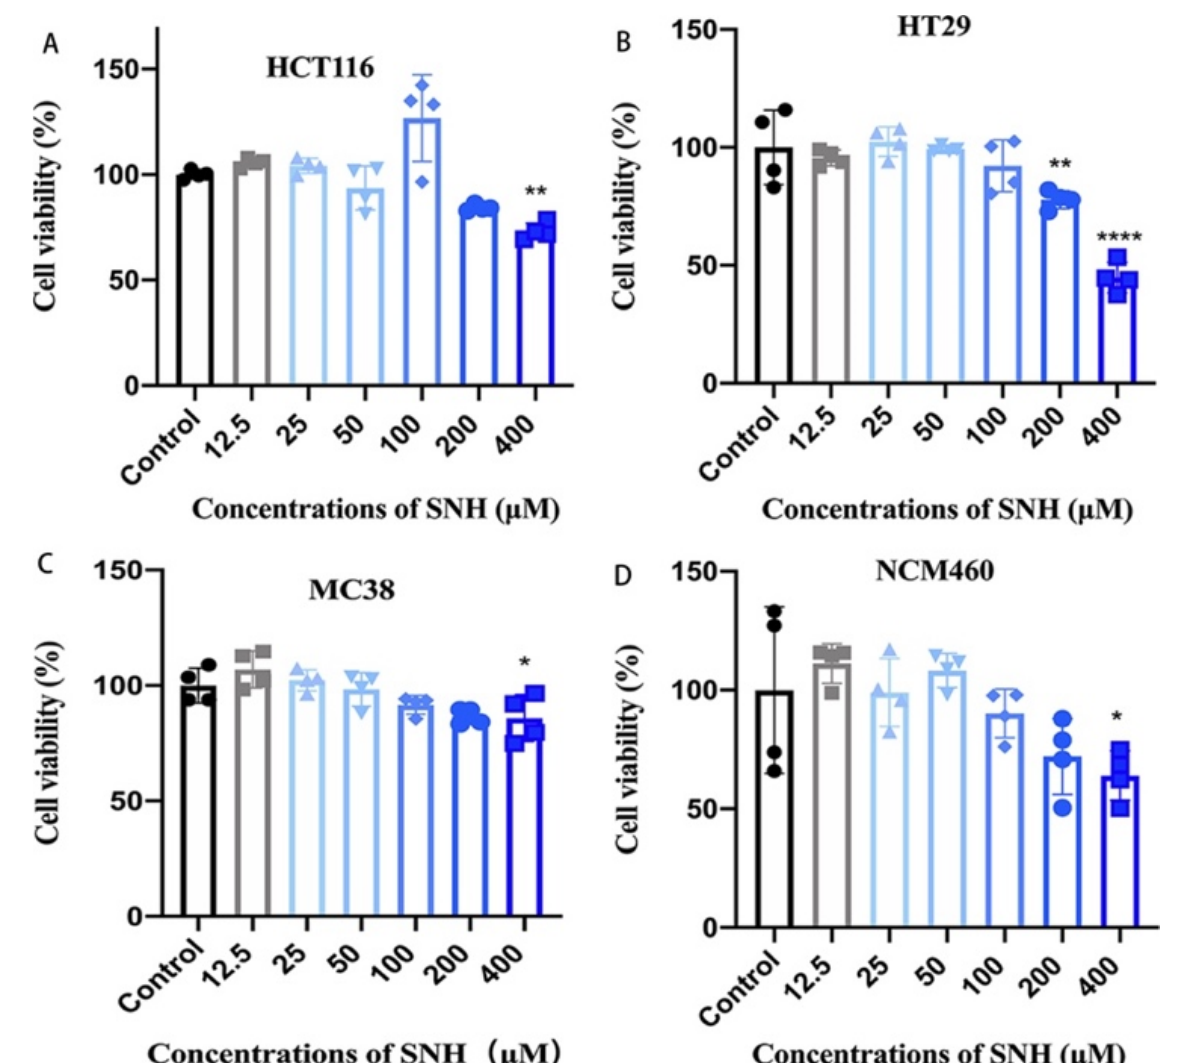
Figure 3. Cytotoxicity of SNH on different CRC cell lines and colon epithelial cells. Cell viability of human colon cancer cells HCT116 ( A ), HT29 ( B ), murine colon cancer cells MC38 ( C ), and human colon epithelial cells NCM460 ( D ) treated with various concentrations of SNH (12.5 μ M–400 μ M) for 72 h. Results were representative of three independent experiments performed in triplicates and were expressed as mean ± SD. p Value < 0.05 was considered statistically significant. * p < 0.05, ** p < 0.01, **** p < 0.0001, vs. Control (PBS vehicle group).